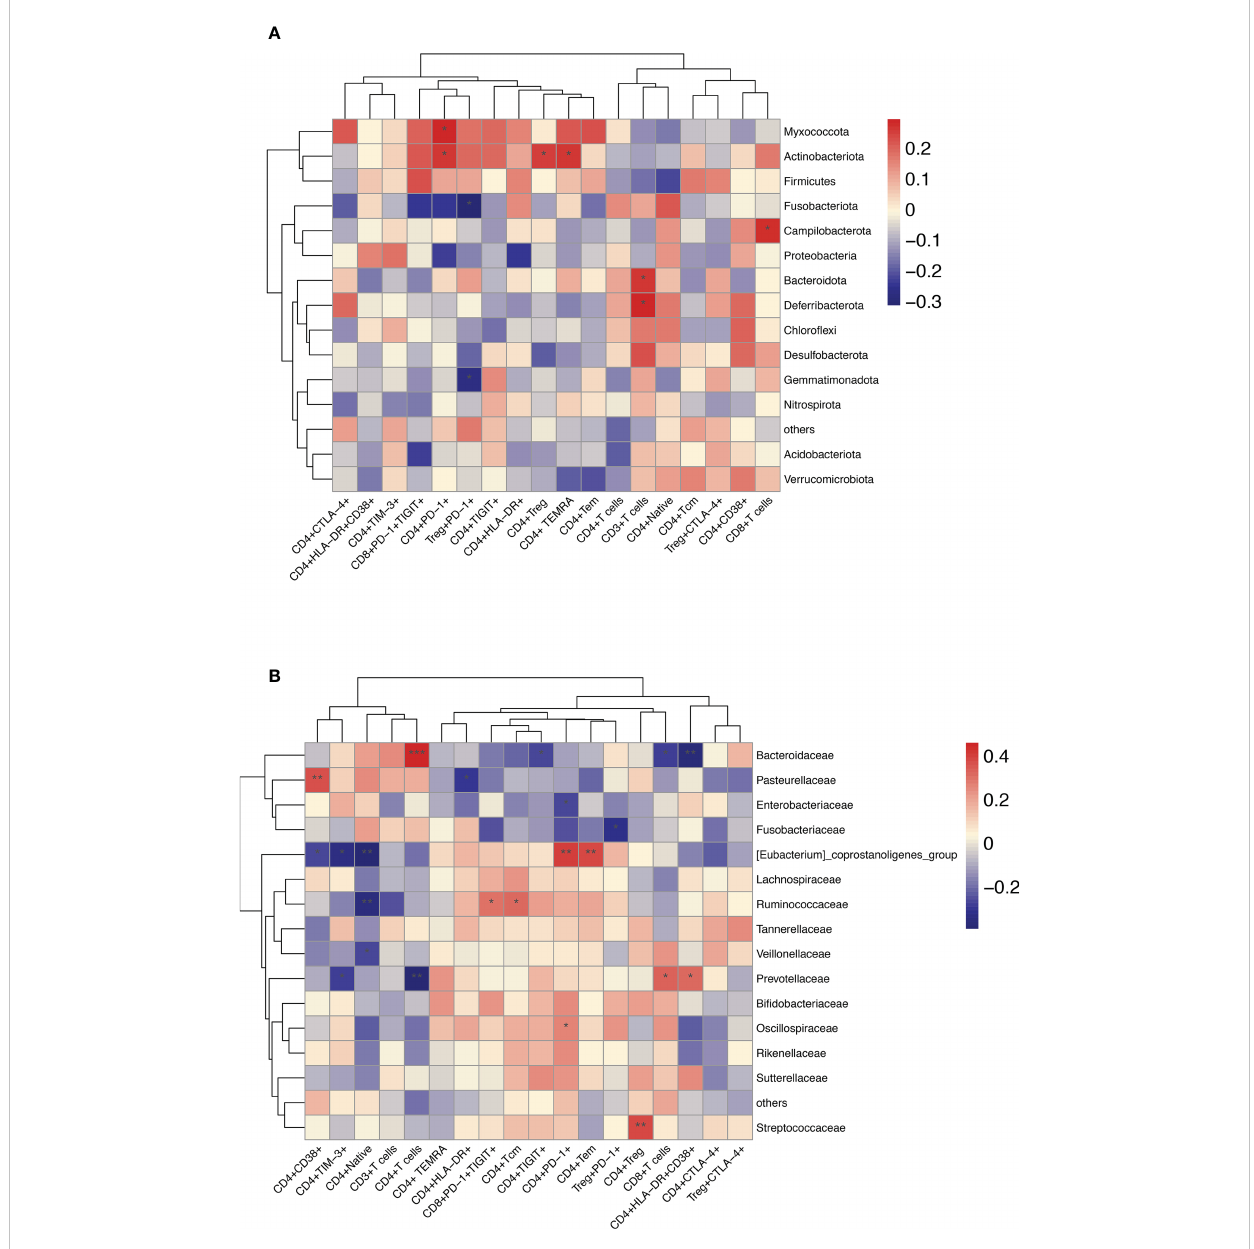
FIGURE 10 Enriched species in the microbiome of participants with HBV-HCC were correlated with the peripheral immune response. Heatmap of Spearman ’ s rank correlation of enriched species in the microbiome and T cell immune responses at the phylum (A) and family (B) level with HBV-HCC group. Color legend represents correlation coef fi cient; “ + ” denotes signi fi cant correlation (P < 0.05) after Benjamini – Hochberg correction. *P < 0.05, **P < 0.01, ***P <